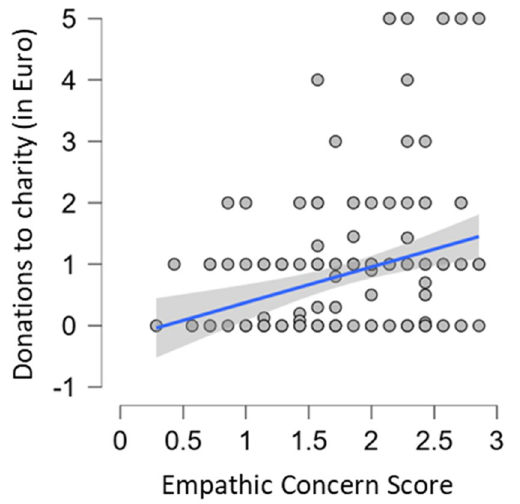
Figure 2. Amount of individual donations to charity (in Euro) in relation to empathic concern scores. Shaded area: credible interval (95%).